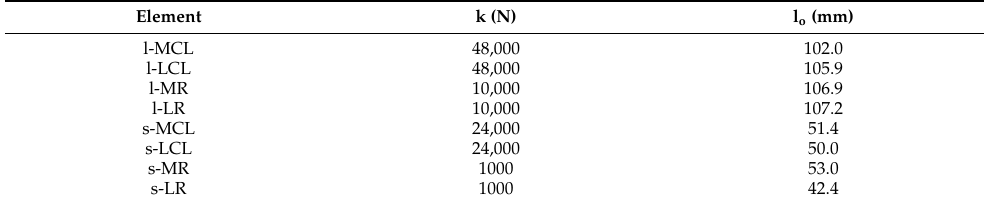
Table A1. Characteristic parameters of the spring elements.